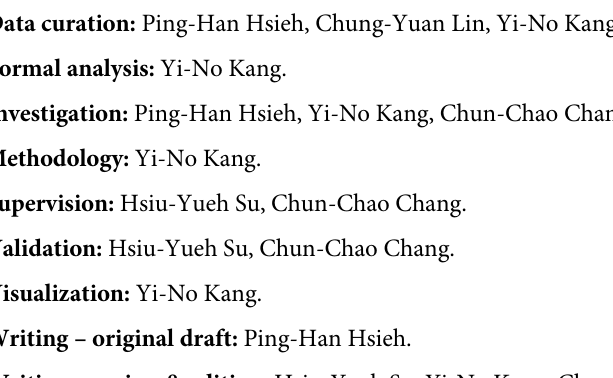
S1 Table. Database and search strategy. S2 Table. Risk of bias. S3 Table. Further information of the included randomized clinical trials. S4 Table. Regression by inclusion year and total parenteral nutrition timing. S5 Table. Summary of surface under the cumulative ranking curve analysis.